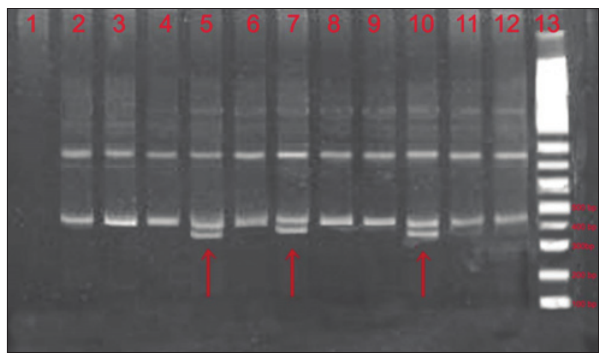
Figure-2: 8% polyacrylamide gel electrophoresis and single strand conformation polymorphism (SSCP) analysis of polymerase chain reaction (PCR) amplified product of exon 3. Lane 1: Control blank, Lane 2-12: SSCP analysis of different samples. Arrow indicating a PCR product producing an extra lower band, Lane 13: DNA Table-2: Depiction of gene and genotype frequency of Exon 3 of MSTN gene by SSCP. Gene Genotype frequency